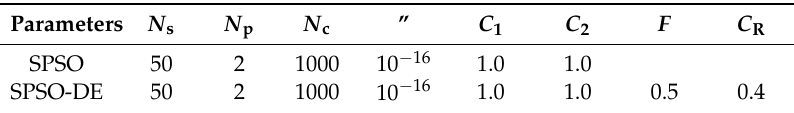
Table 3. System control parameters of the SPSO and hybrid SPSO-DE algorithms in retrieving monomodal Gamma